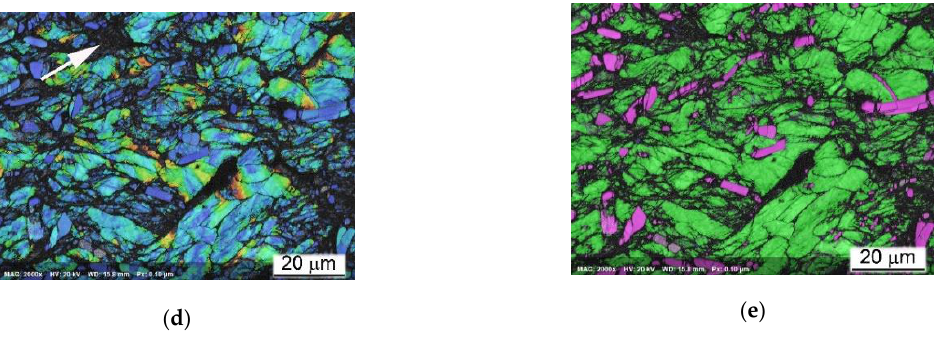
Figure 20. SEM EBSD results of Ti64BEPM + 10TiB sample after QSC tested with rate 10 −3 s −1 . The shown area is the same as in Figure 19e. Phase map images ( a , b , e ), where α-phase is shown in green, β-phase in blue and TiB in magenta. ( c )—Pattern Quality Map. ( d )—Grain Misorientation Map.